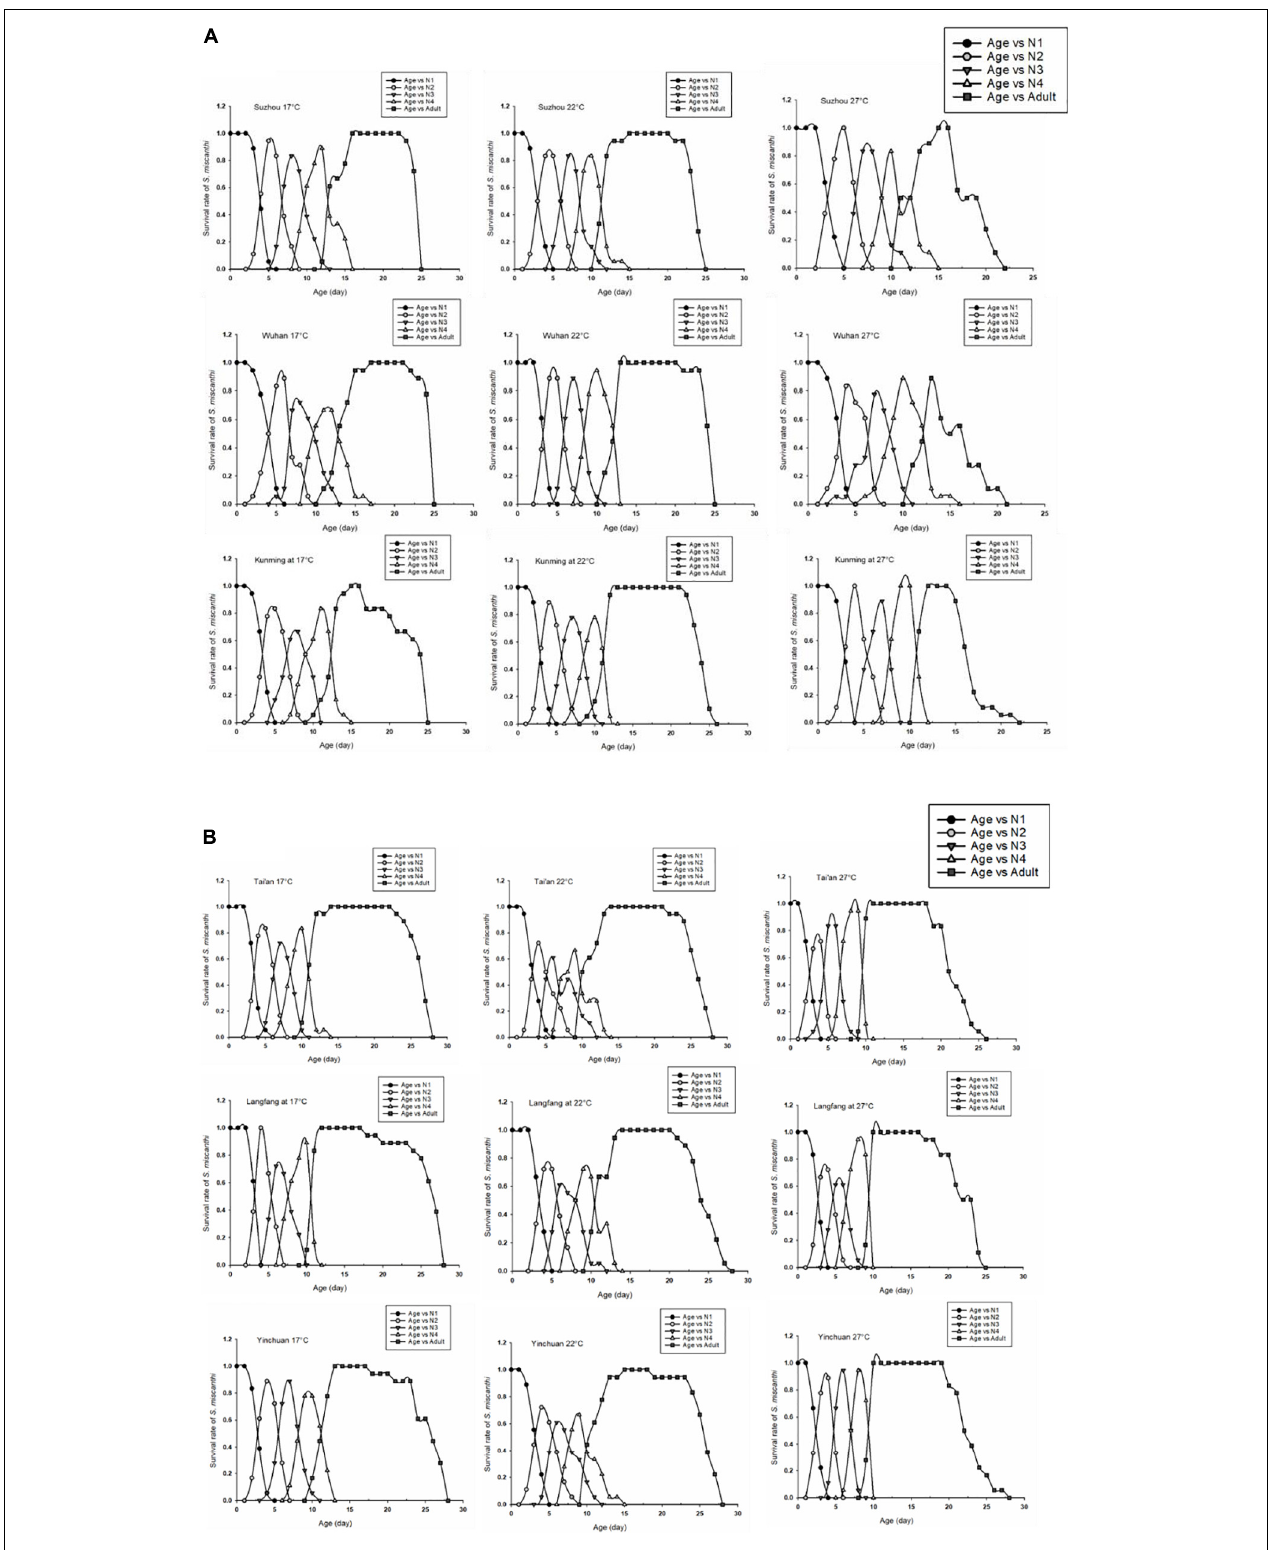
FIGURE 6 | Age-stage-specific survival rate ( s xj ) of S. miscanthi on different geographical populations at different degrees (17, 22, and 27 ◦ C). (A) Southern populations (B) northern populations.